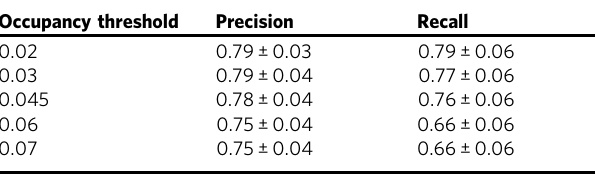
Precision and recall values for prediction of WATsite occupancy using regression neural network at fi ve different levels of occupancy threshold